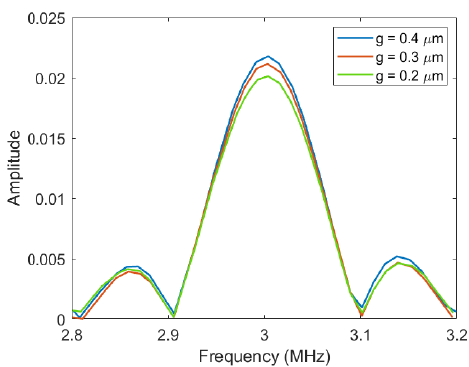
Figure 10. The fractional bandwidth of different cavity heights.